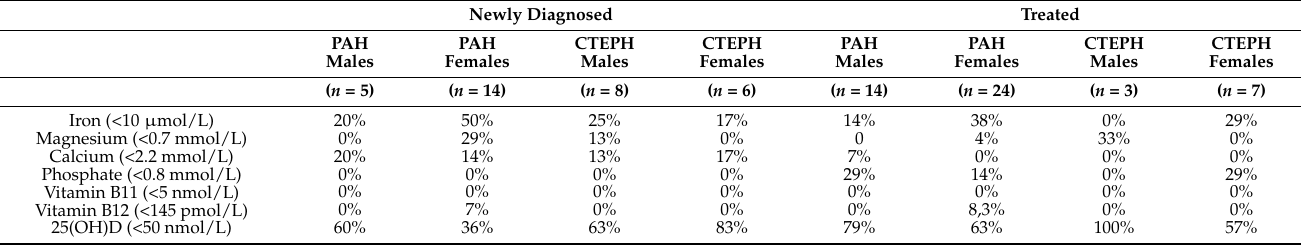
Table 4. Percentage of patients below the reference value for micronutrients in newly diagnosed and treated in gender subgroups of PAH and CTEPH